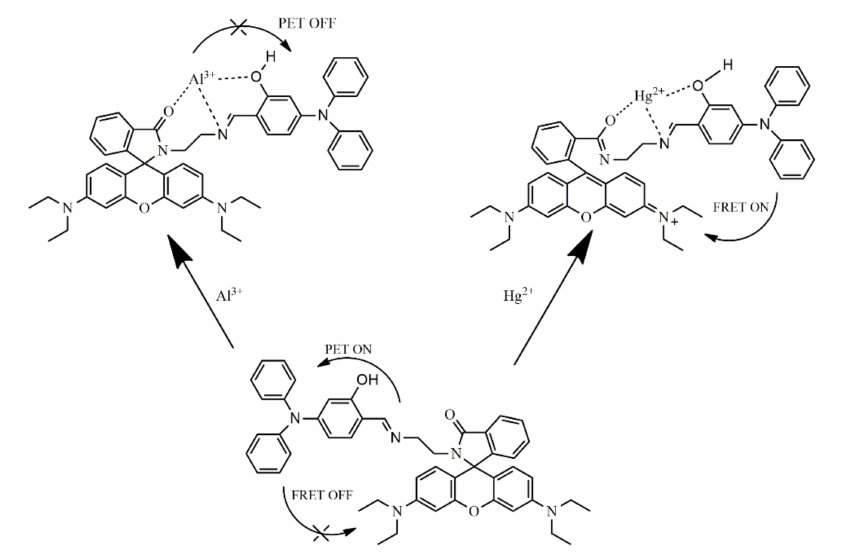
Figure 54. Proposed sensing mechanism of TR (Table 4, No. 5) for Al 3+ and Hg 2+ [110]. Hazra A., et al. synthesized a rhodamine-based sensor, named RBO (Table 4, No. 6) through the reaction of N-(rhodamine-6G)lactam-ethylenediamine and 2,1,3-benzoxadiazole- 4-carbaldehyde [111] and used for selective detection of Al 3+ and Hg 2+ in 10 mM HEPES buffer in water: ethanol (1:9, pH = 7.4) (Figure 55). Furthermore, the induced response by Al 3+ and Hg 2+ was recovered with the assistance of fluoride or sulfide ions, thus opening a path for the construction of logic gates.